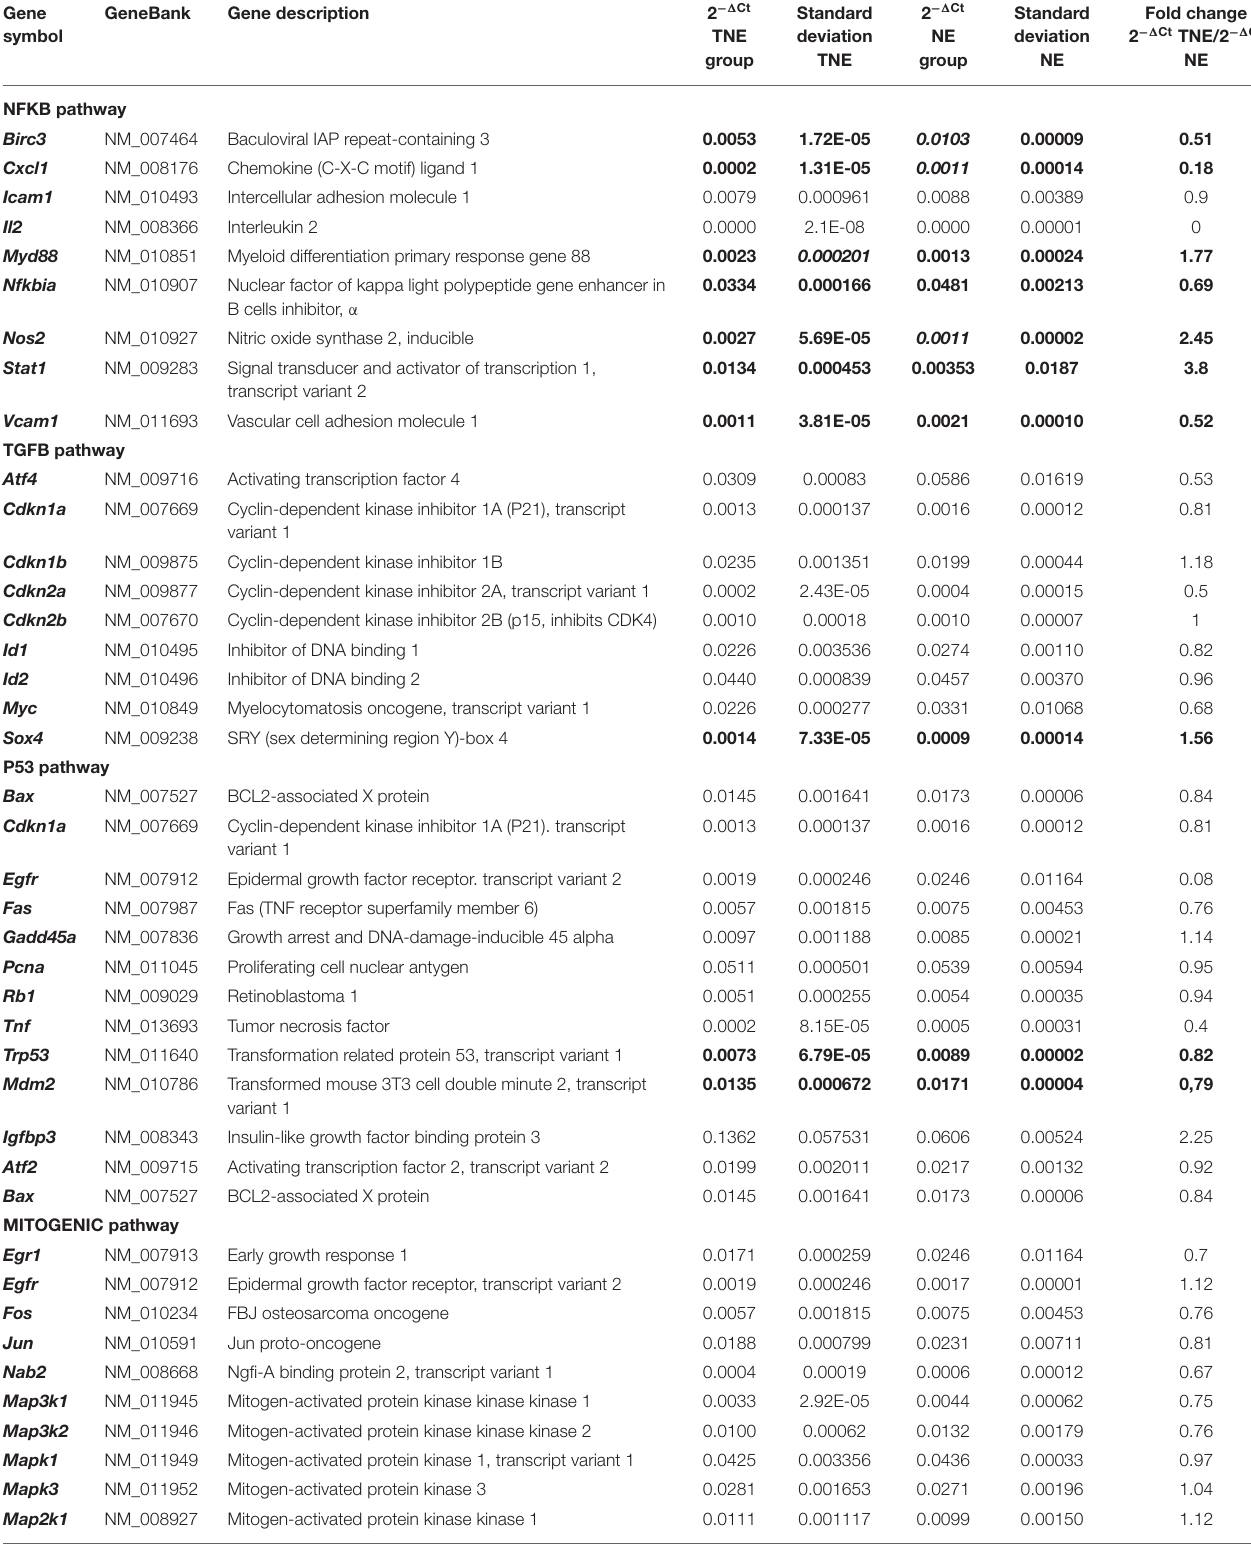
TABLE 1 | The list of 84 analyzed genes (divided into nine signaling pathways) and their relative expression levels in groups TNE and NE as measured by a real-time PCR array. Gene